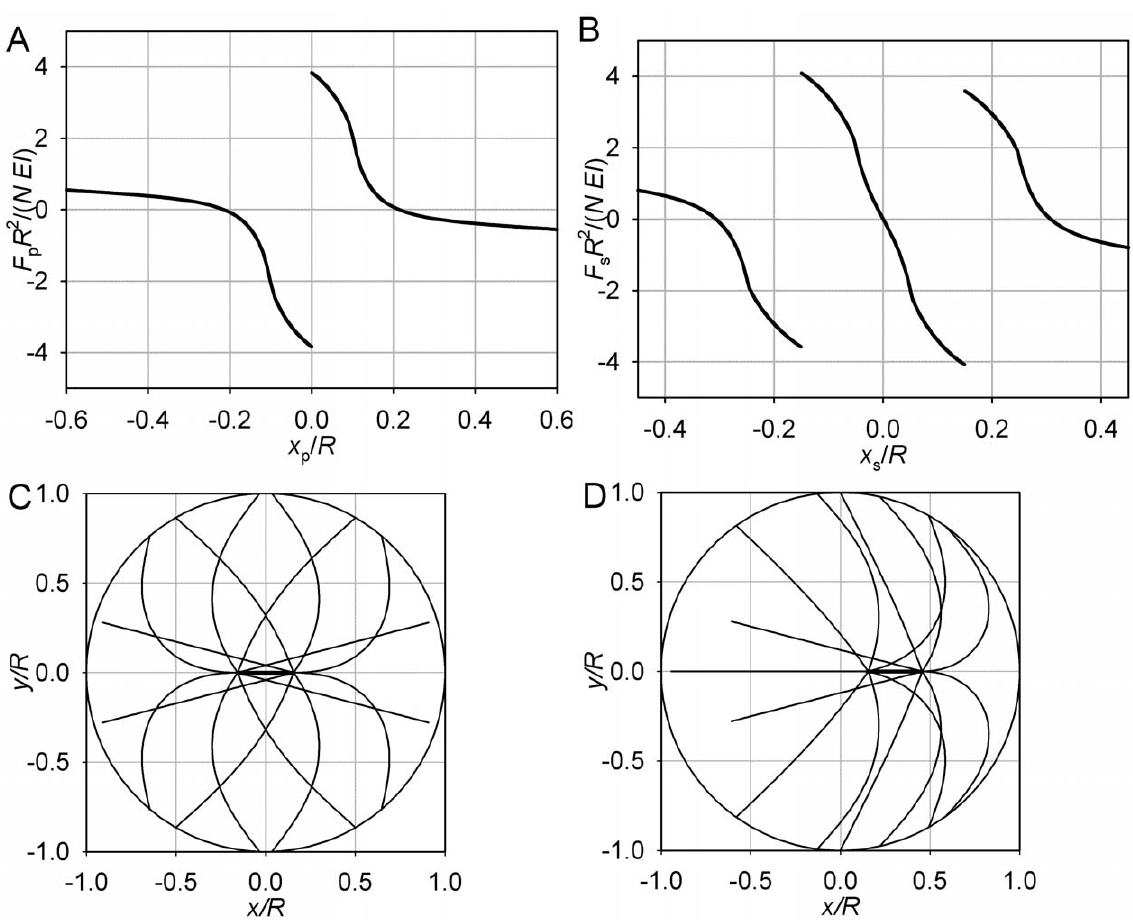
Figure 4. Limiting case of h max = p , long microtubules. (A) Pole force function. (B) Spindle force function. (C, D) Equilibrium conformations. L =1.1 R , S =0.3 R . Plotting conventions as in Fig. 3.